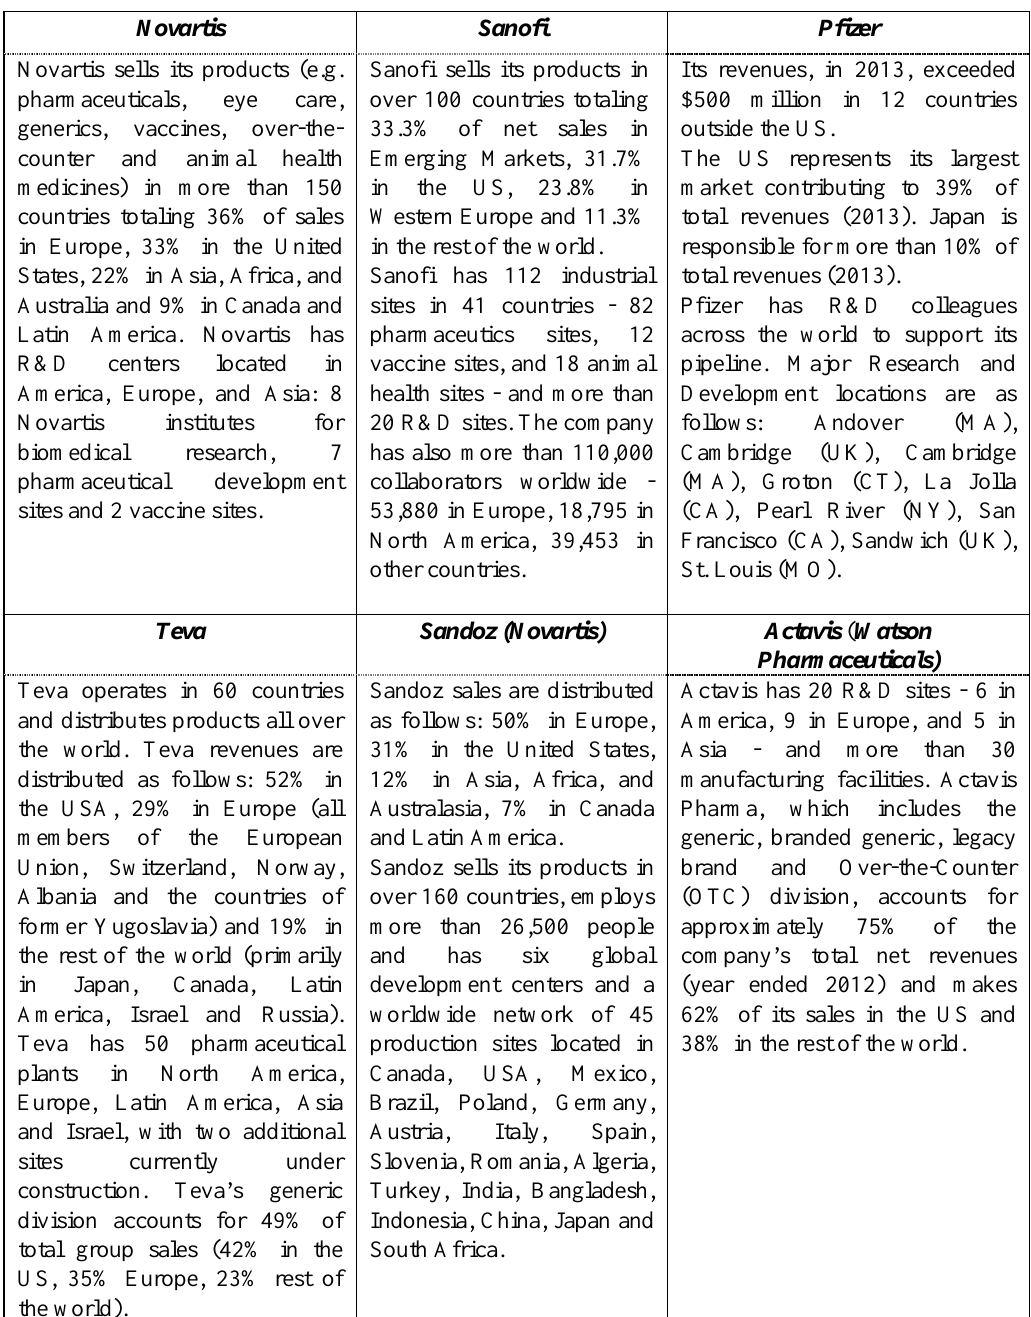
Figure 2: Sales by Area and Geographical Distribution of Six Among the Main Originator and Generic